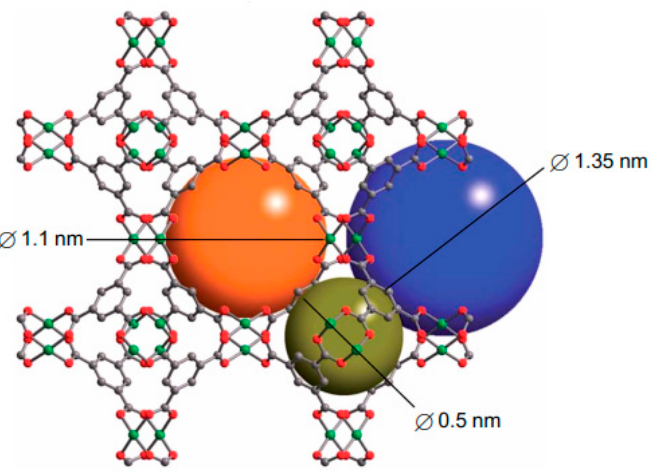
Figure 4. Crystal structure of HKUST-1 with three types of pores designated by differently colored spheres. Reprinted with permission from [79]. Copyright © The Royal Society of Chemistry 2014. All rights reserved.